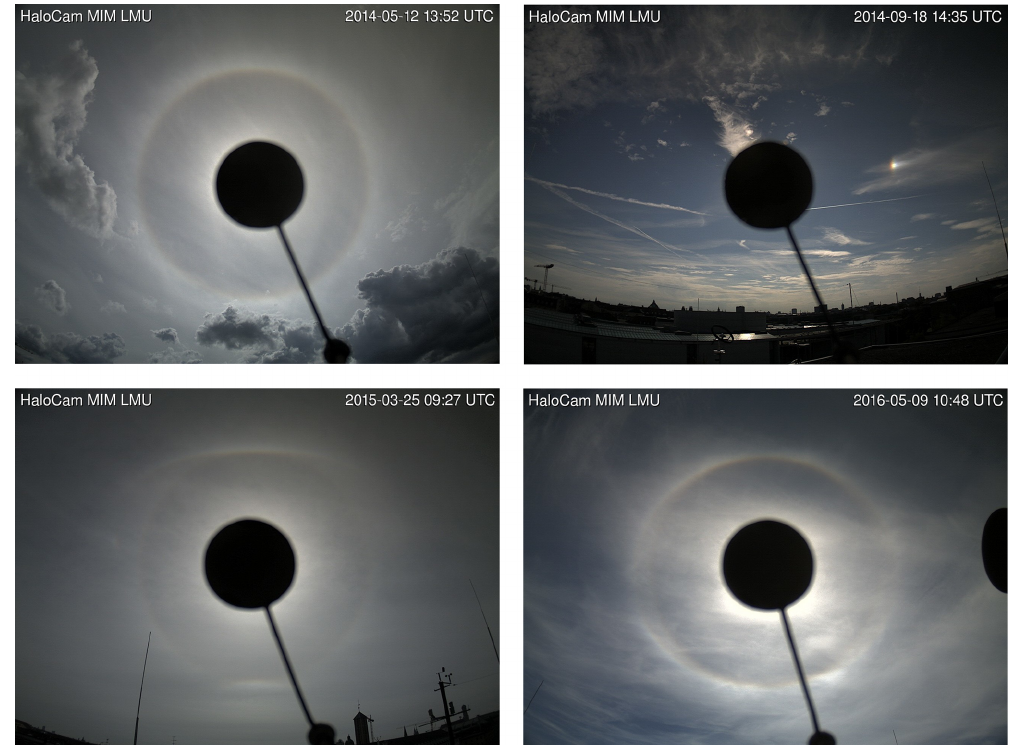
Figure 1. Examples of halo displays observed at the Meteorological Institute of LMU in Munich. The Sun is blocked by a black circular shade to avoid stray light and saturation of the camera sensor. Top left: 22 ◦ halo. Top right: right-hand 22 ◦ parhelia or sundog. Bottom left: faint 22 ◦ halo with upper and lower tangent arcs. Bottom right: 22 ◦ halo with circumscribed